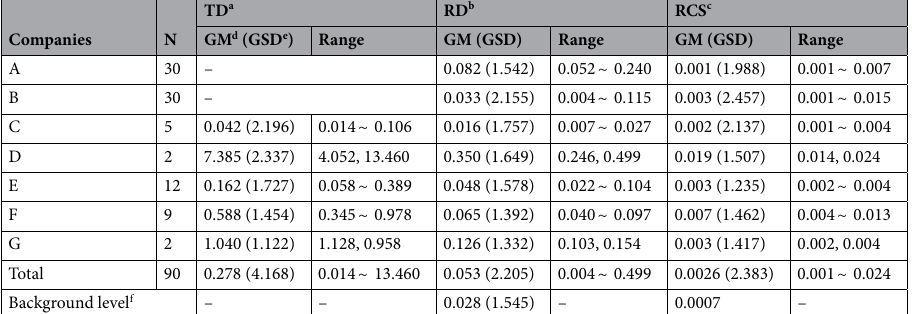
Table 3. Exposure levels (mg m –3 ) of TD, RD, and RCS by company. a Total dust. b Respirable dust. c Respirable crystalline silica. d Geometric mean. e Geometric standard deviation. f The background RCS and RD concentrations are the values obtained by the authors of this study through another research project in 2018 24